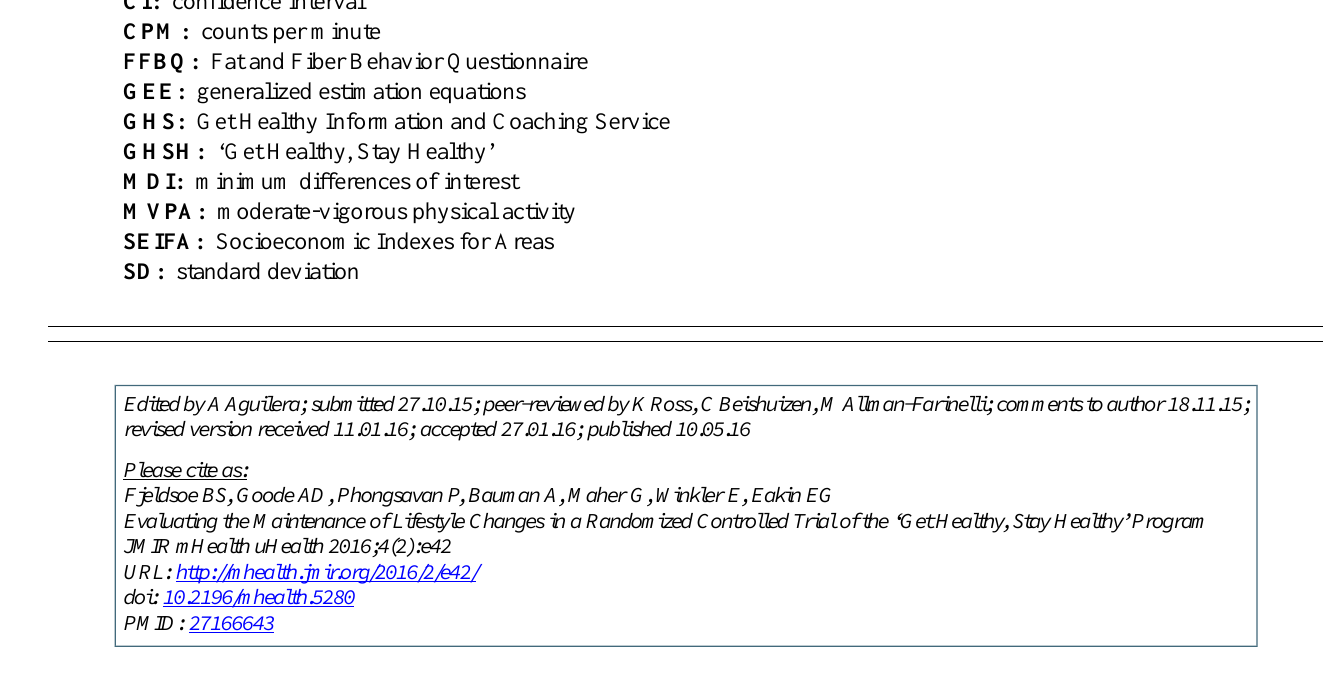
FFBQ: Fat and Fiber Behavior Questionnaire GEE: generalized estimation